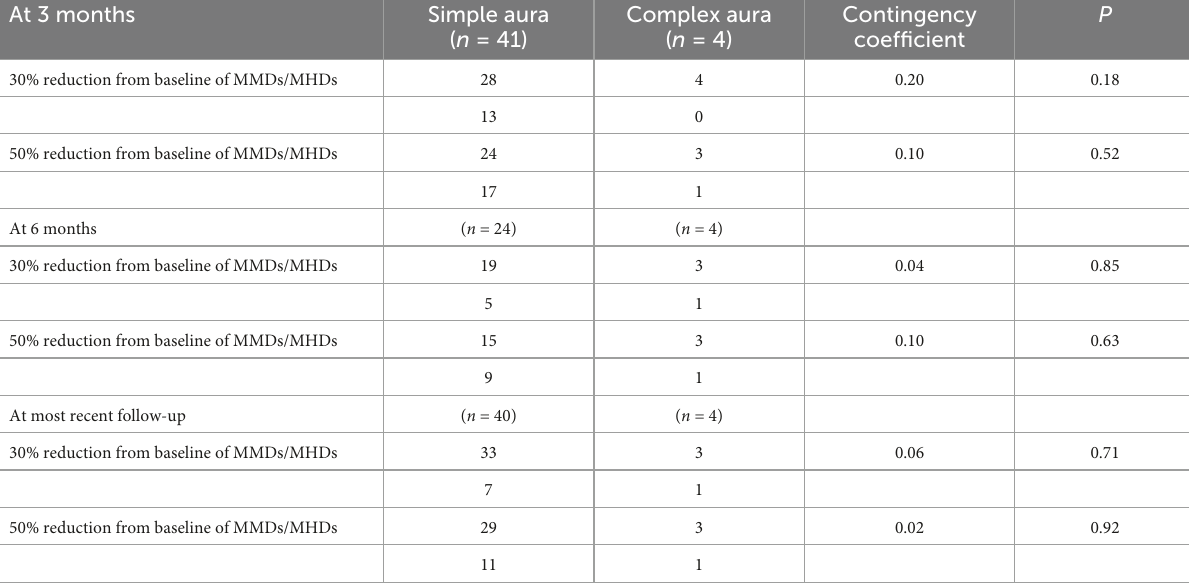
TABLE 3 Correlation between complexity of aura and preventive treatment